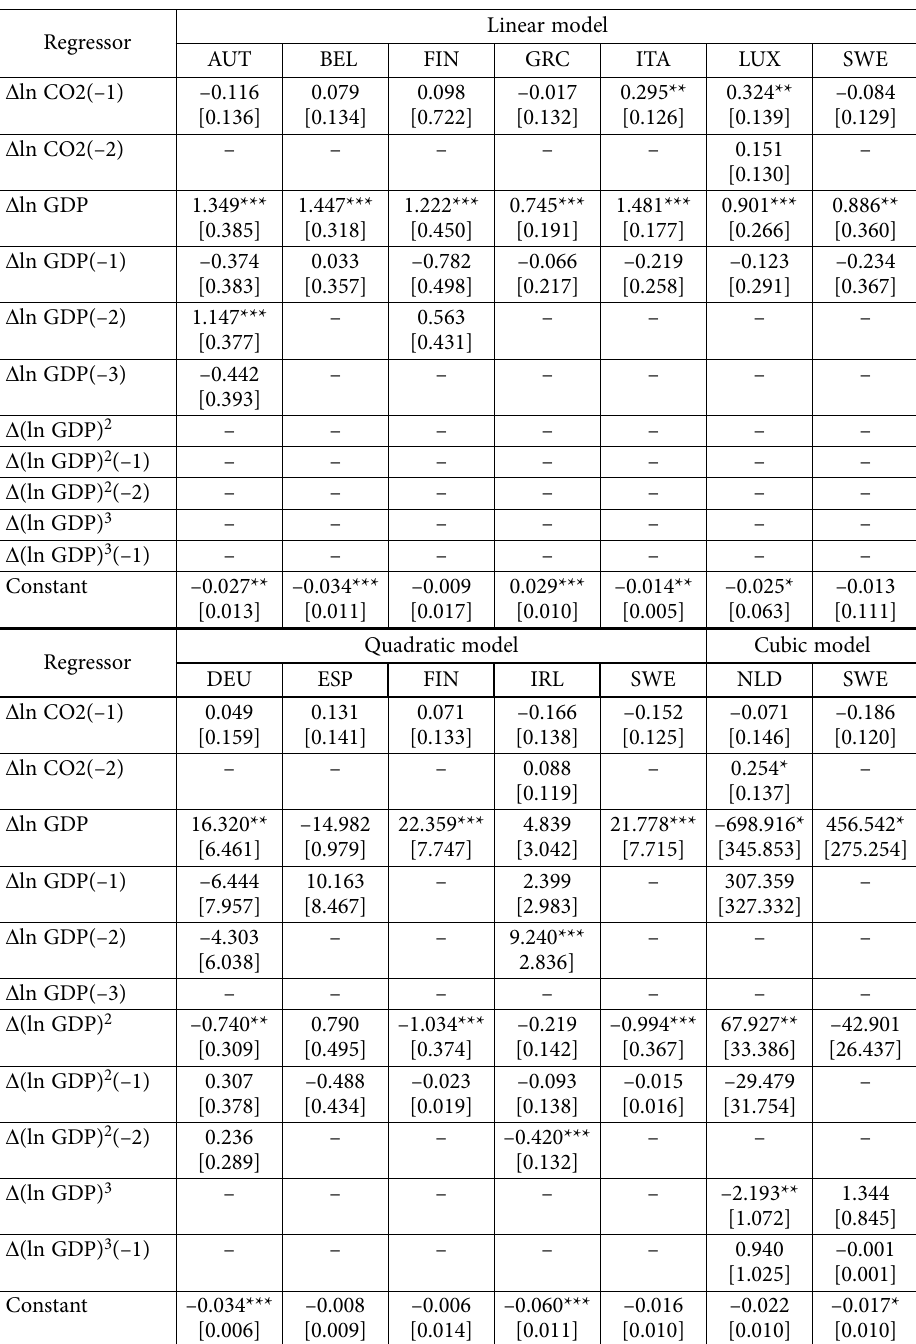
Table 3. Estimated short-run coefficients for the significant ARDL